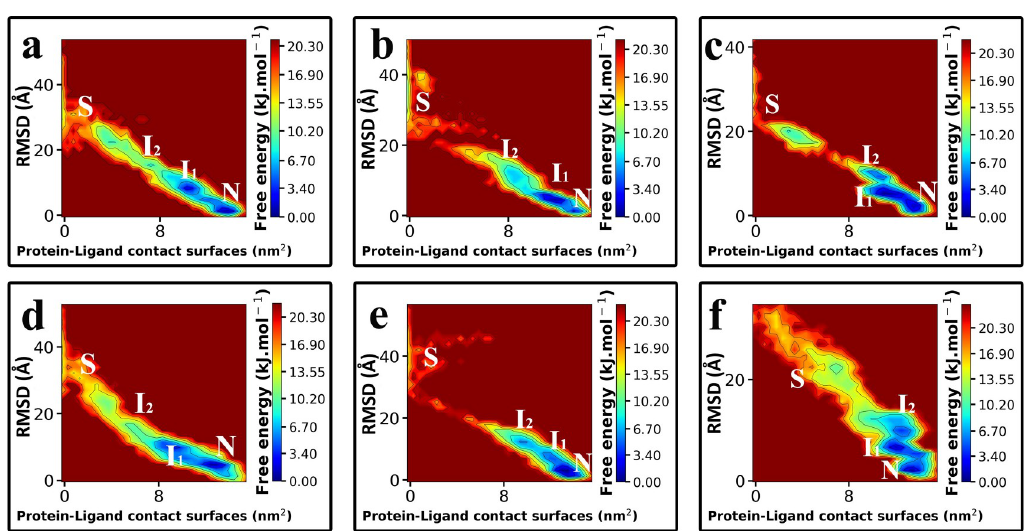
Fig 3. The “out-of-equilibrium” Free Energy Landscapes (FEL) of the unbinding pathways of Indinavir. a, b, c , from the HIV protease and, d, e, f, from the HTLV-1 protease. The stable states of Indinavir during the unbinding pathway are indicated by capital letters; Native (N), Intermediate (I 1 , I 2 ), and Solvated